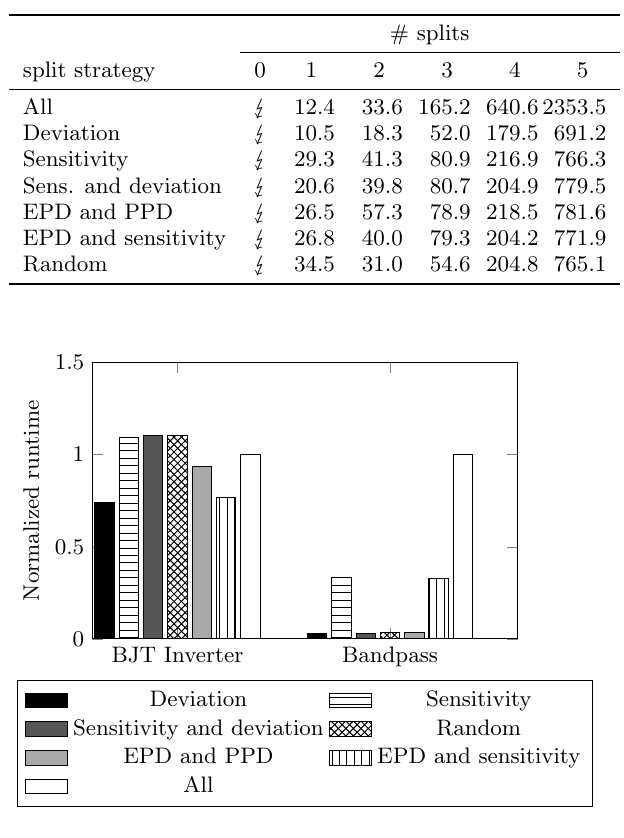
Figure 15: Simulation runtime for different split strategies